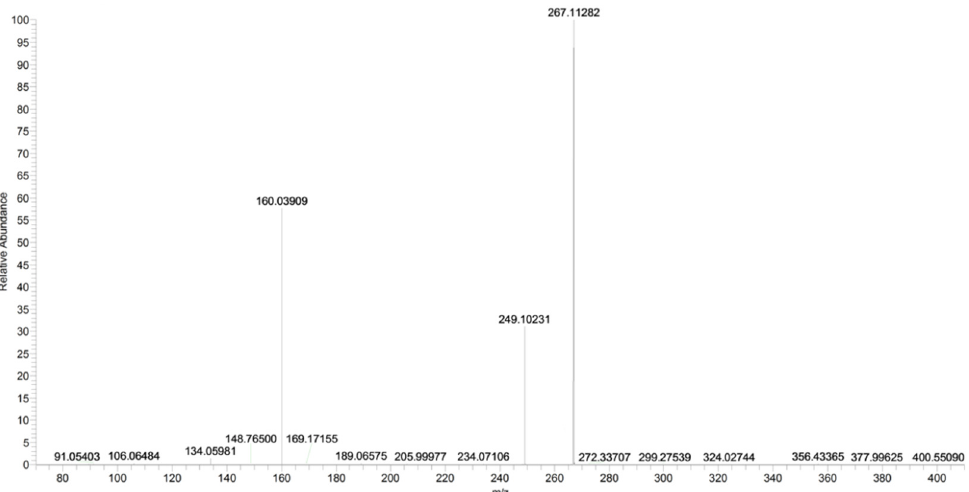
Figure 16. Product ion scan of URB754 compound obtained by HRMS.